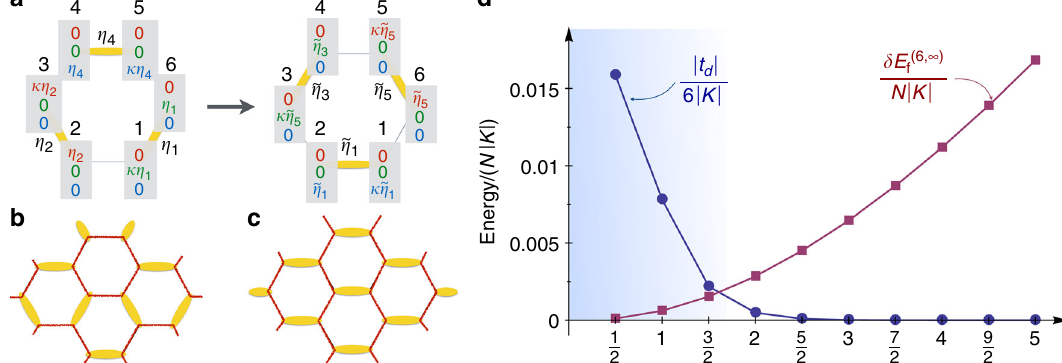
Fig. 7 Breakdown of Toric code description at S ≲ 3/2. a The tunneling process that shifts the dimers around a hexagon, with a quantum mechanical amplitude t D . b The star dimer pattern of Fig. 2 (repeated here for comparison with c ), where empty bonds form closed hexagons (red lines). c Dimer pattern where empty bonds form in fi nite strings (red lines). d Competition between kinetic energy (blue line, rescaled by a factor 6 K j j to get the energy contribution per site, in units of K j j ) and the dimer freezing energy δ E (6, ∞ ) (red line, rescaled by N K j j to get the energy contribution per site, in units of K j j ). The latter is obtained by subtracting the potential energies (calculated at the interacting spin-wave level) of the two states depicted in b ,